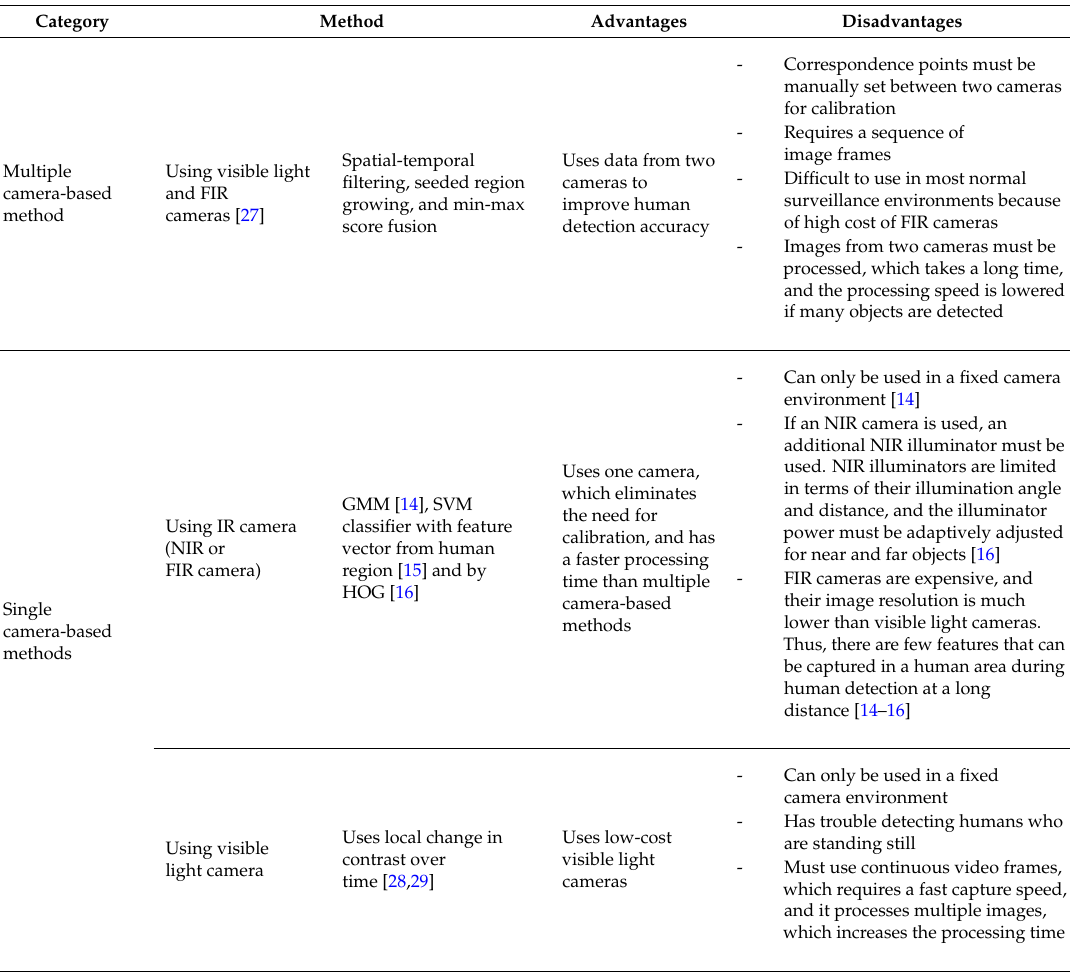
Table 1. Comparison of proposed method and previous study